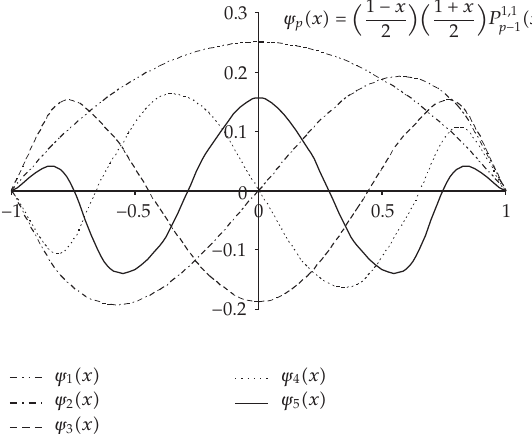
Figure 1: First few bubble modes generated using Jacobi polynomials (cid:3) P 1 , 1